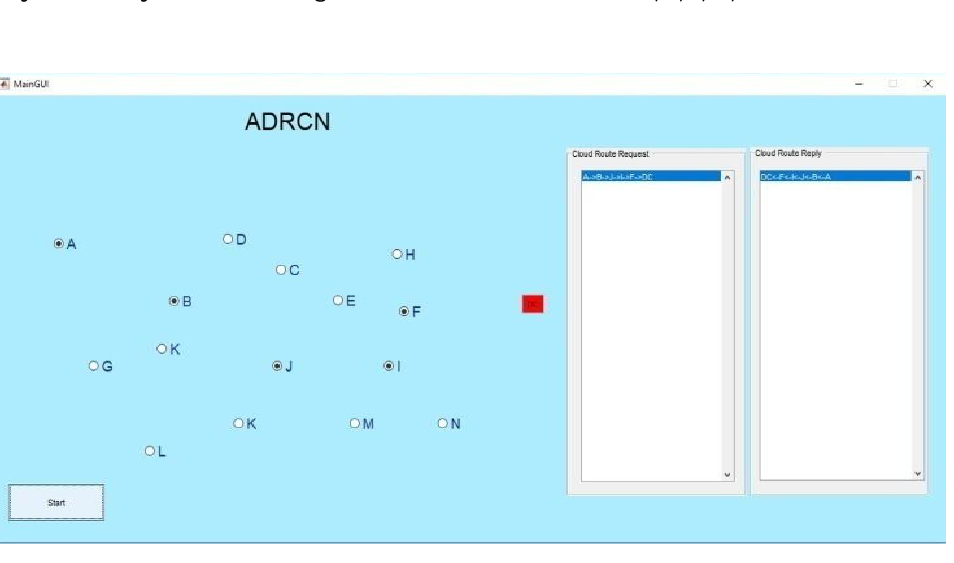
Figure 3. Basic outline of ADRCN